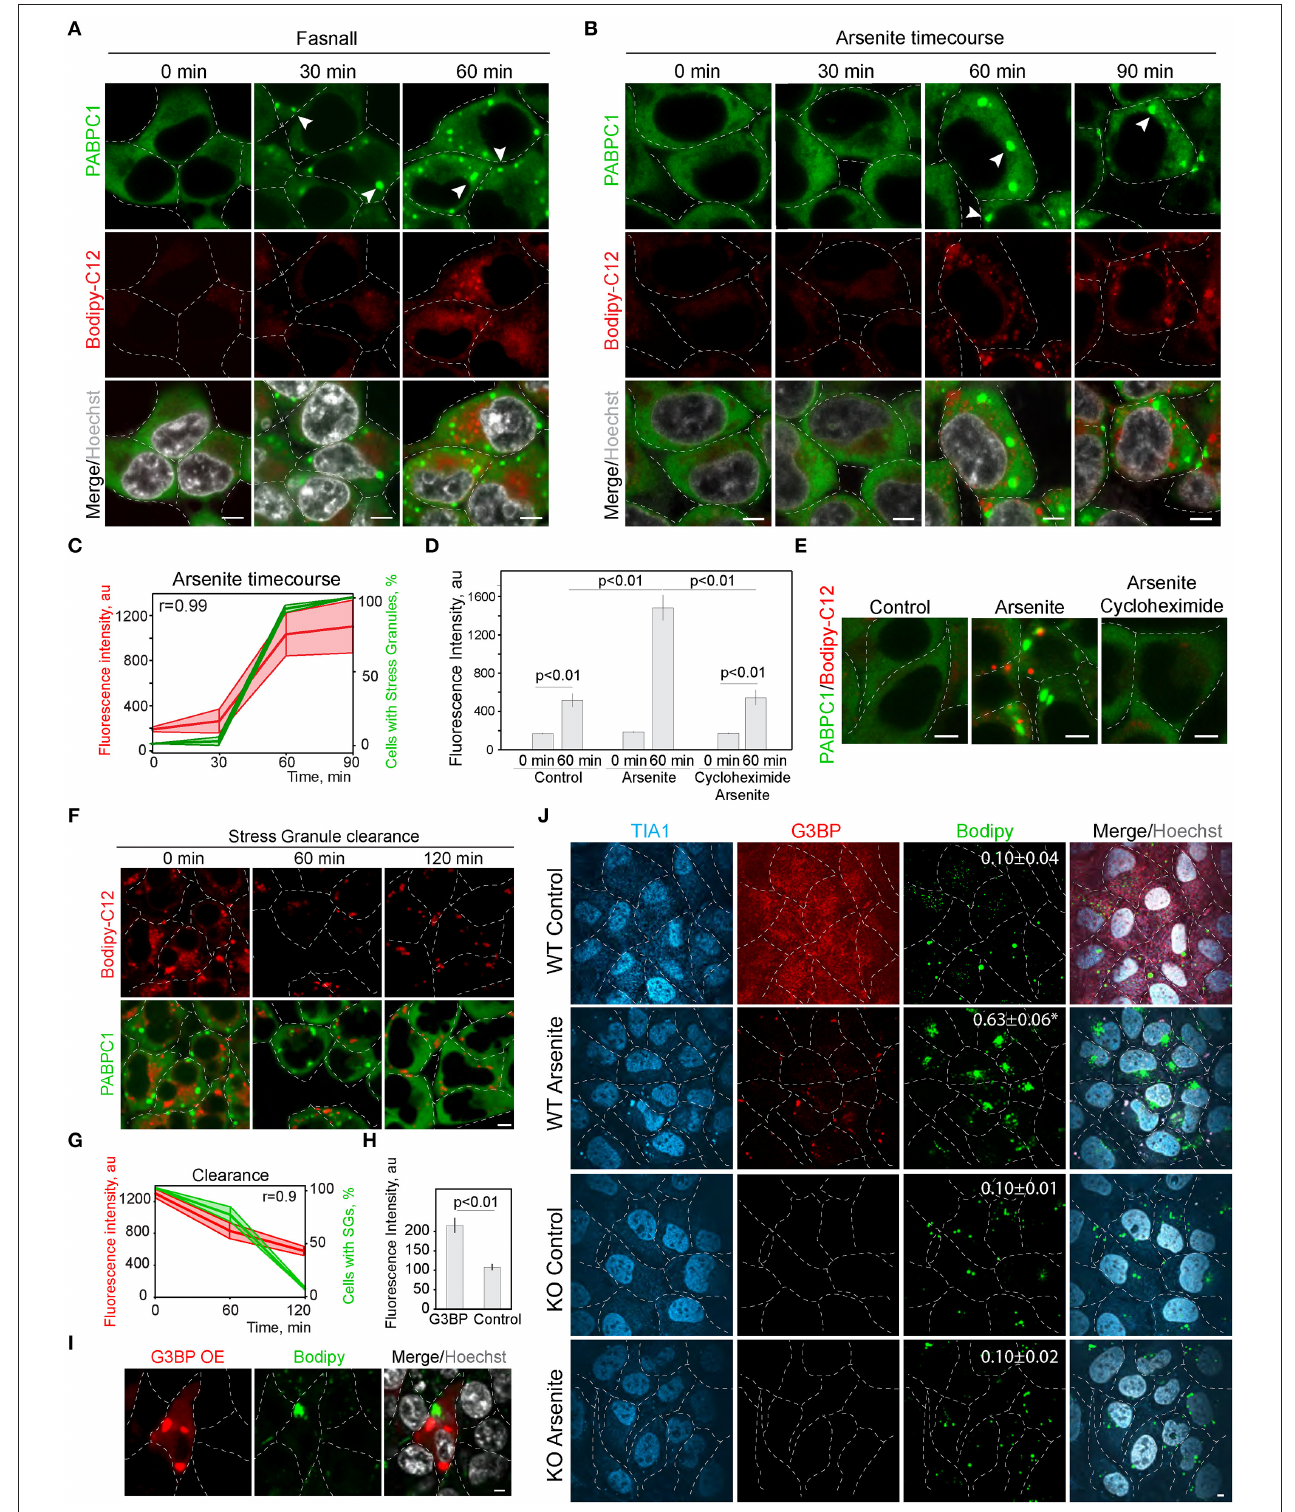
FIGURE 2 | Inhibition of stress granule formation reduces lipid droplet formation. (A) SG formation timeline during Fasnall treatment showing fatty acid accumulation. Cells expressing CRISPR/Cas9-tagged PABPC1-DDR2 were incubated with Fasnall (100 µ M) for indicated amounts of time, LD dye (Bodipy-C12, 1 µ M) was added 30min prior to the imaging together with Hoechst (10 µ g/ml). Representative confocal images are shown. Arrows indicate SGs. Scale bar, 5 µ m (see also,